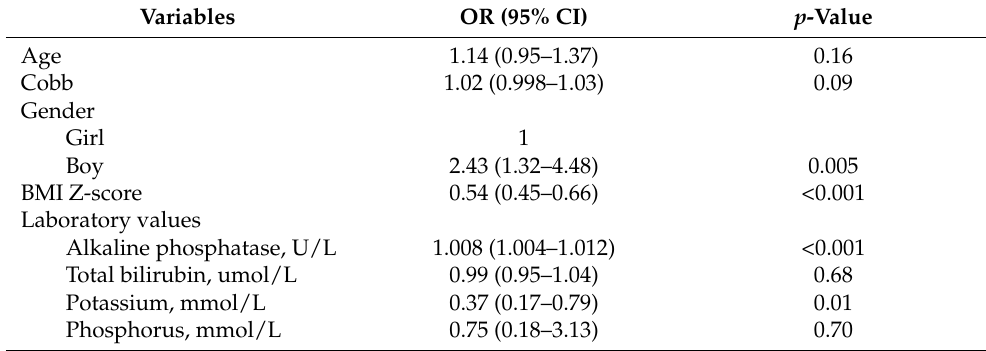
Table 4. Logistic regression analysis for independent predictors of BMD Z-scores of ≤−